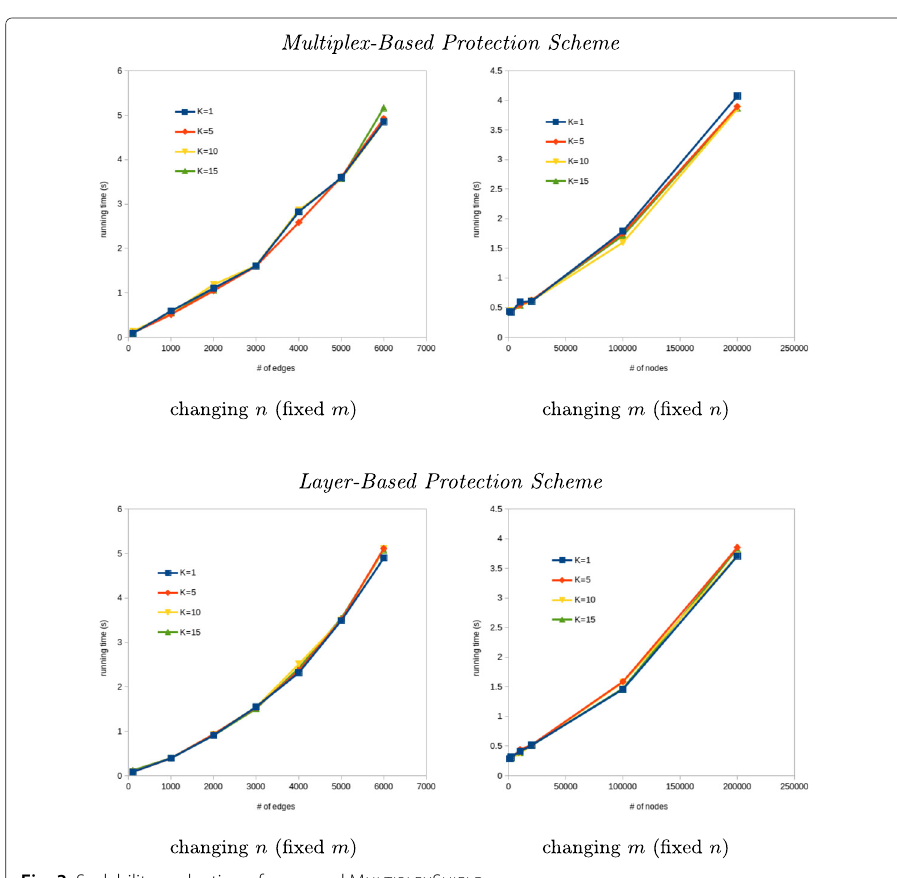
Fig. 3 Scalability evaluation of proposed M ULTIPLEX S